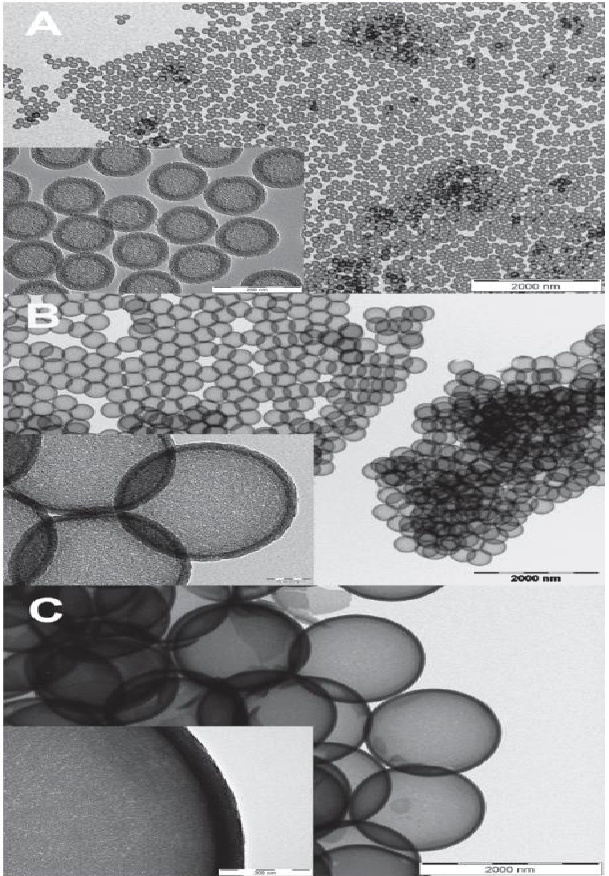
Figure 10. TEM images of a hollow silica sphere with different silica particles. The contrast between the core and shell shows the absence/presence of a hollow cavity. The size of PS was ( A ) 140 nm, inset scale bar = 200nm ( B ) 400 nm, inset scale bar = 100nm and ( C ) 1500 nm, inset scale bar = 200 [83].